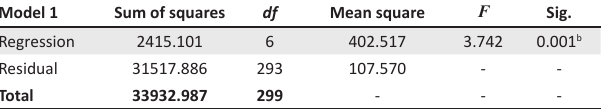
TABLE 2: Summary of multiple regression showing composite contributions of independent variables to the challenges faced by children. Model